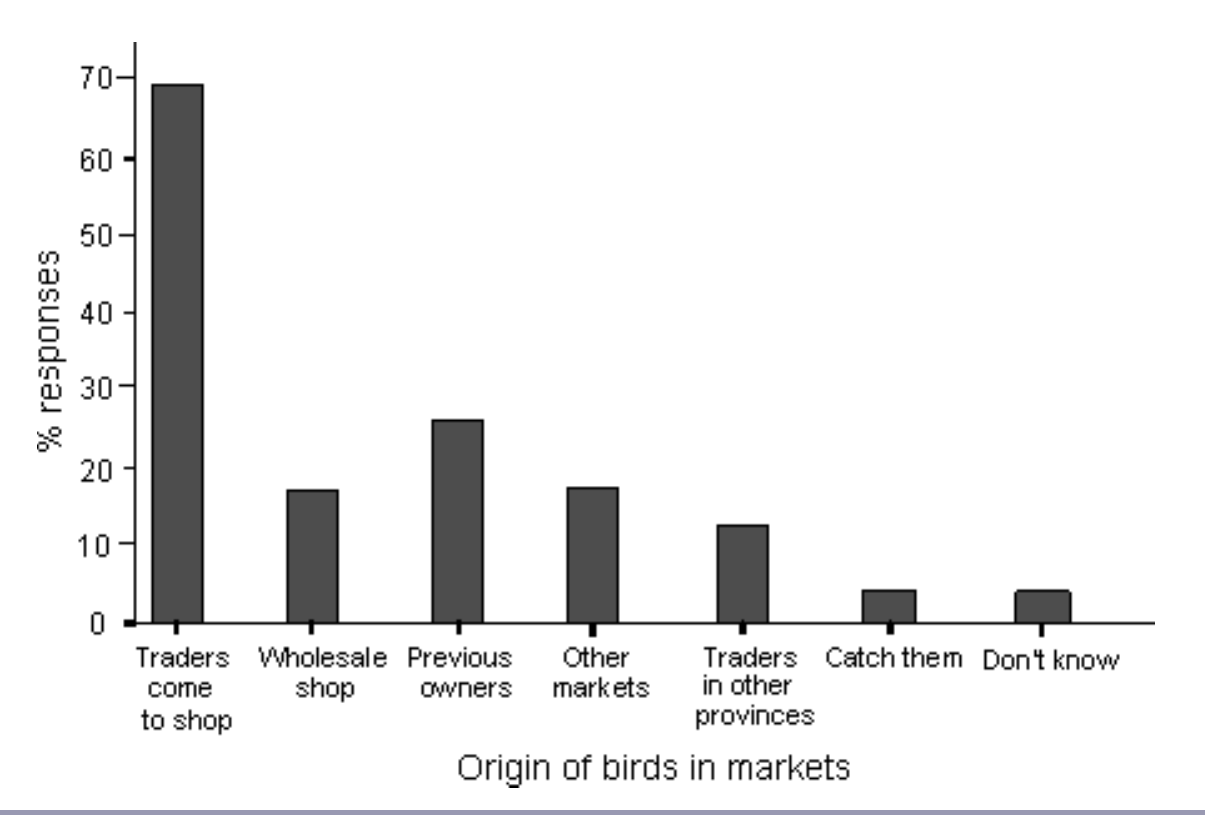
Fig. 1 . Sources of market birds reported by vendors during surveys of Hanoi bird markets in